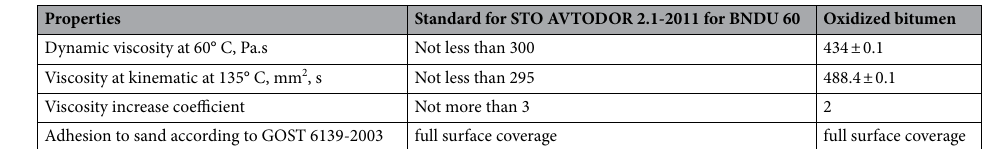
Table 7. Rheological measurements and results of the interactions between stone and asphalt of oxidized bitumen.